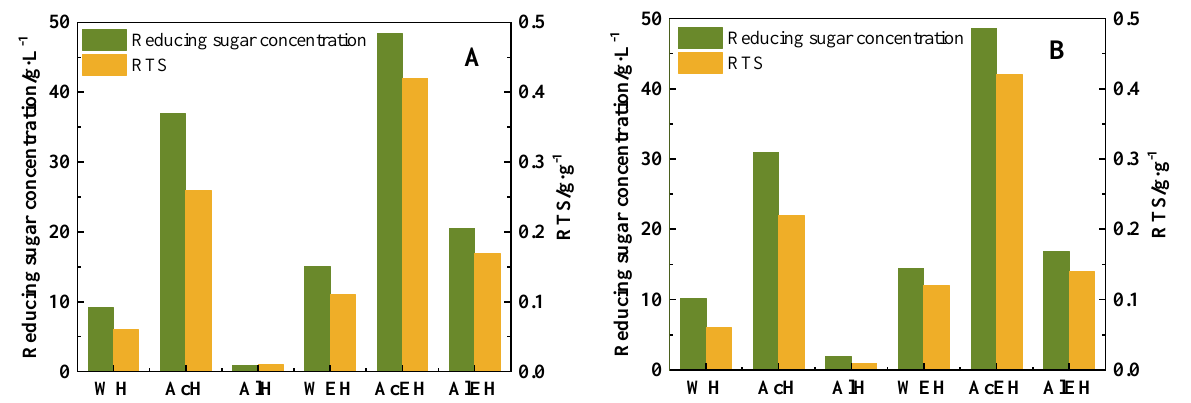
Figure 3. The concentration of reducing sugar and RTS of different straw hydrolysates. ( A ) CS hydrolysates. ( B ) SS hydrolysates.